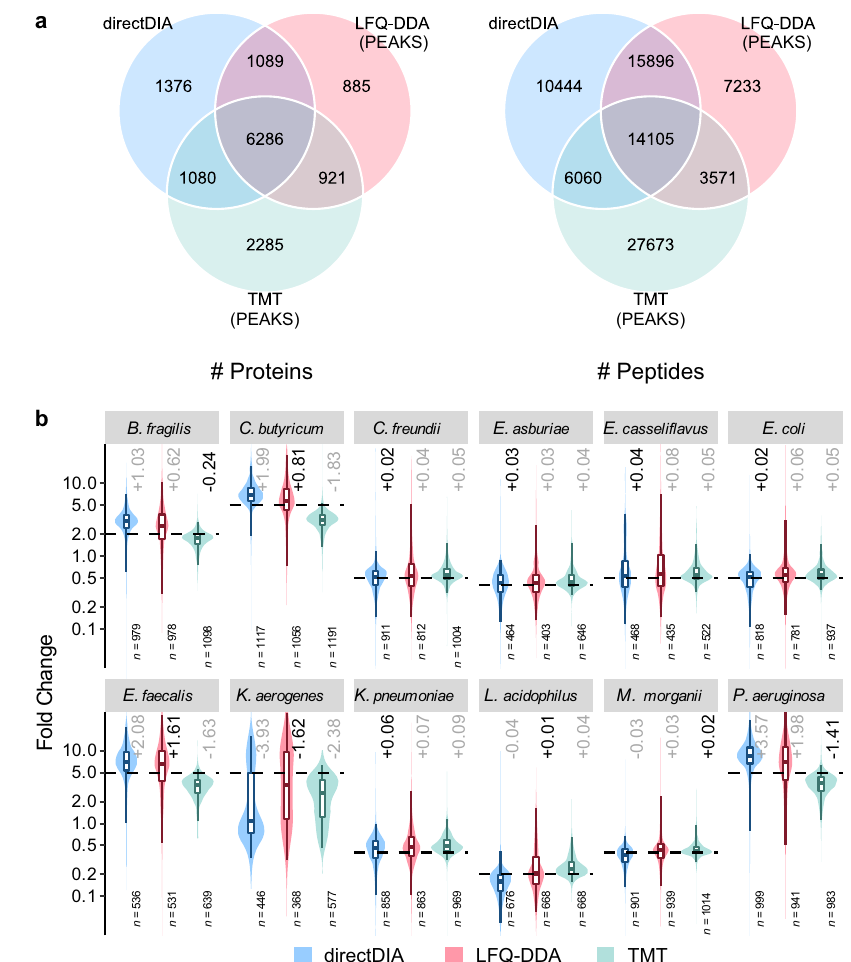
Fig. 2 Performance evaluation of directDIA, LFQ-DDA, and TMT on the simulated microbial community of 12 species. a Overlap of proteins and peptides shared in at least 2/3 replicates in each sample group by different methods. b Measured fold change (FC) values of protein abundance between sample 3 (as numerator) and sample 1 (as denominator) for each species calculated based on the average of the replicates of each sample. Only proteins quanti fi ed in at least 2/3 replicates of each sample group and uniquely belonging to one species were taken into consideration. Numbers ( n ) of quanti fi ed proteins are indicated for each species. The boxes mark the fi rst and third quantile and the lines inside the boxes mark the median; the whiskers mark 2.5% and 97.5% percentile; outliers are not shown. The theoretical ratios are highlighted as dashed lines. Differences between the measured median FC values and theoretical values are indicated, among which the smallest ones are darkened. Results of the other sample pairs are shown in Supplementary Fig. 14. The DDA and TMT data were analyzed by PEAKS. Source data are provided as a Source Data fi bacterial species composition of the sample. Six bacterial species not at a detectable abundance in the fecal sample were selected and cultured. For each species, the bacterial cell numbers were determined by optical density measurement and plate counting. The bacterial suspensions were mixed with three different cell number ratios to form three samples, wherein the low abundant species counted down to ~0.4% of the cell copies of the 6 species (as shown in Supplementary Table 4). Bacterial proteins were then extracted from the three mixtures. For each mixture, 1 μ g of bacterial proteins were taken and spiked into 99 μ g of microbial proteins extracted from the fecal sample to form the spiked samples. As a result, proteins of the 6 species accounted for 1% weight of the total proteins in the spiked samples. The LFQ-DIA, LFQ-DDA, and TMT data (Supplementary Table 5) were searched against a protein database combining proteomes of the 6 species and protein sequences from the metagenomic sequencing results of the fecal sample (491,768 entries in total). Among the several state-of-the-art software solutions, PEAKS Studio was chosen for LFQ-DDA and MaxQuant 36 for TMT as they